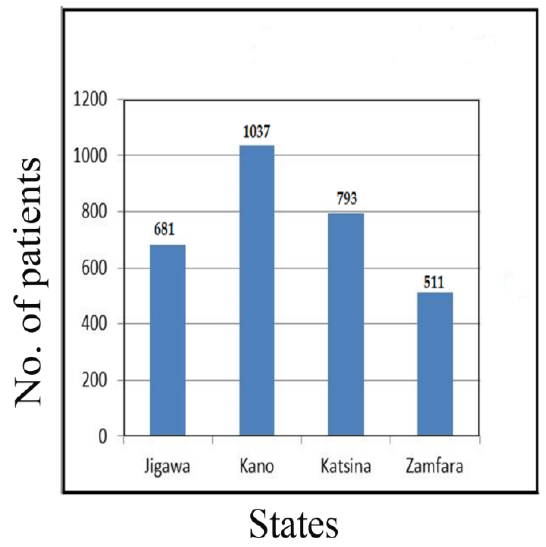
Figure 1. Data collection flow.